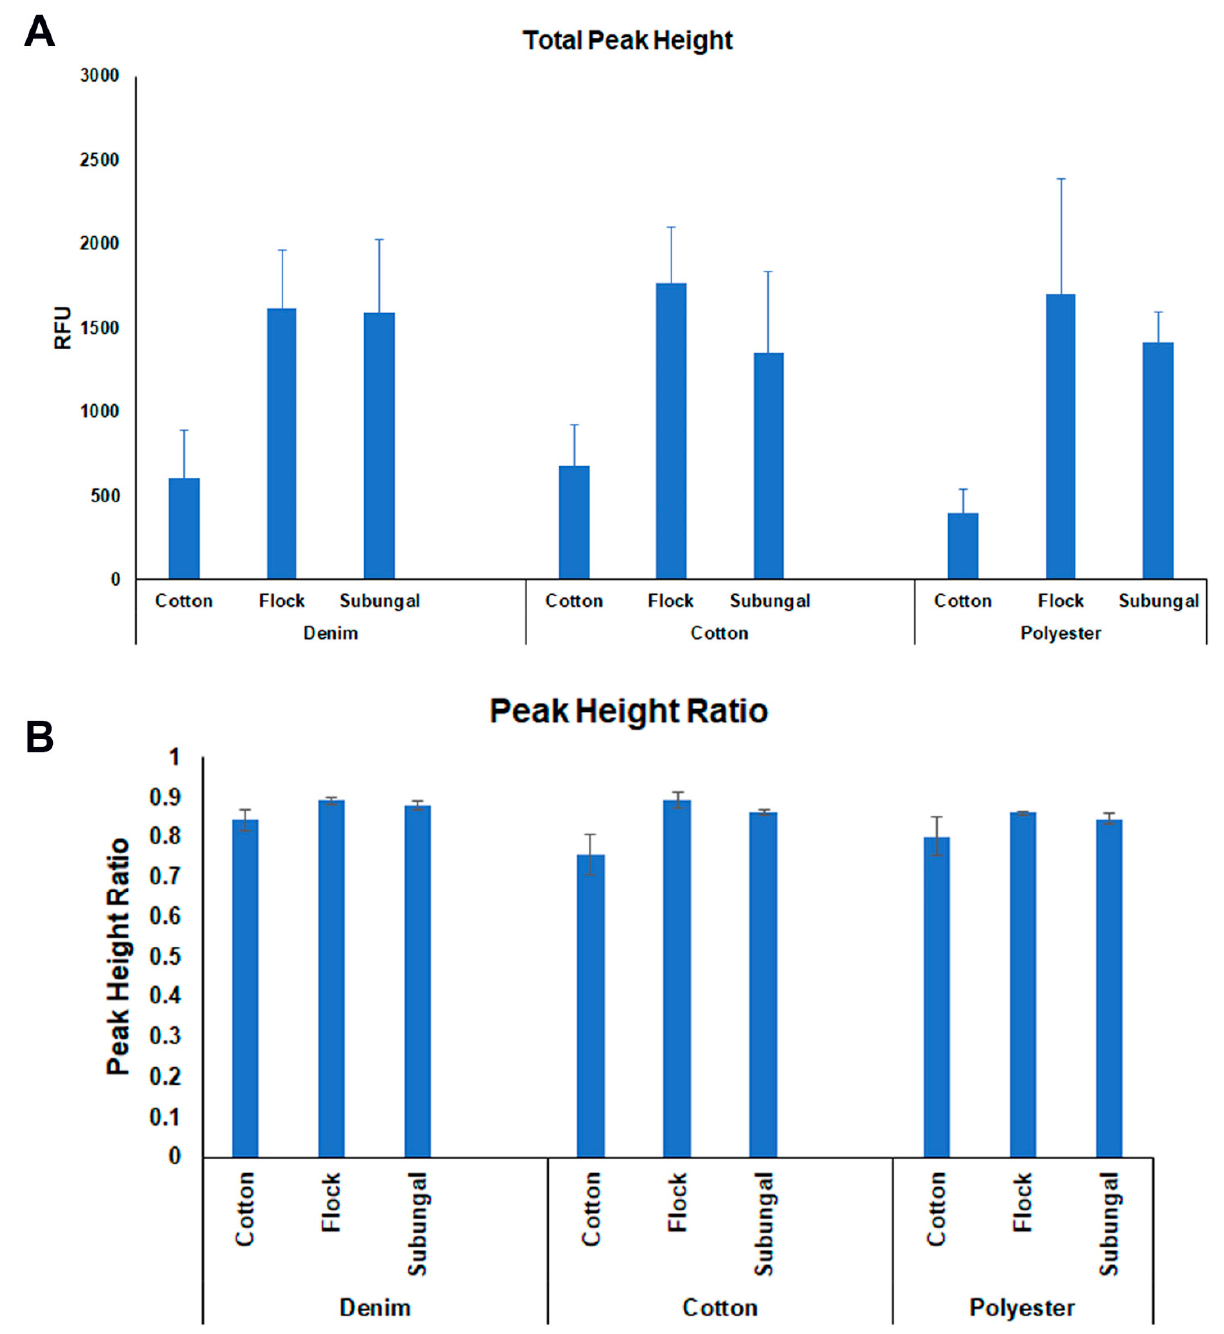
Figure 5. Average of Total Peak Height (TPH) ( A ) and Peak Height Ratio (PHR) ( B ) of the three independent experiments of each fabric and type of swab based on the results of 24 STRs. Total Peak Height (TPH) is represented in Relative Fluorescent Units (RFUs).